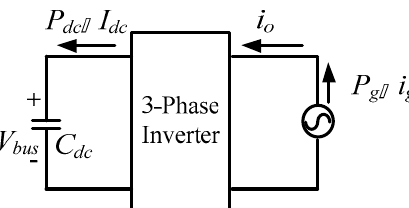
Figure 7. Equivalent circuit of direct current (DC) bus voltage loop.